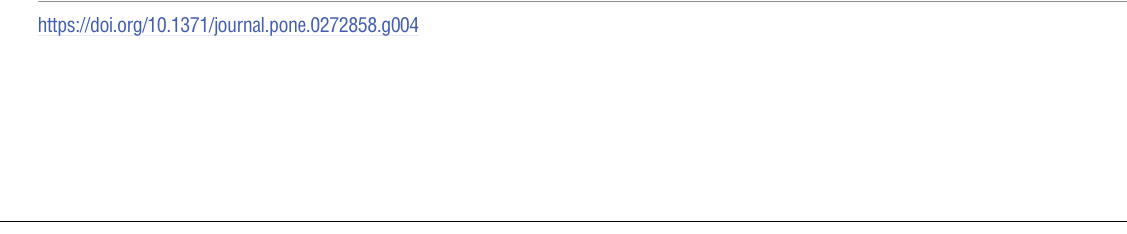
PLOS ONE | https://doi.org/10.1371/journal.pone.0272858 August 23,